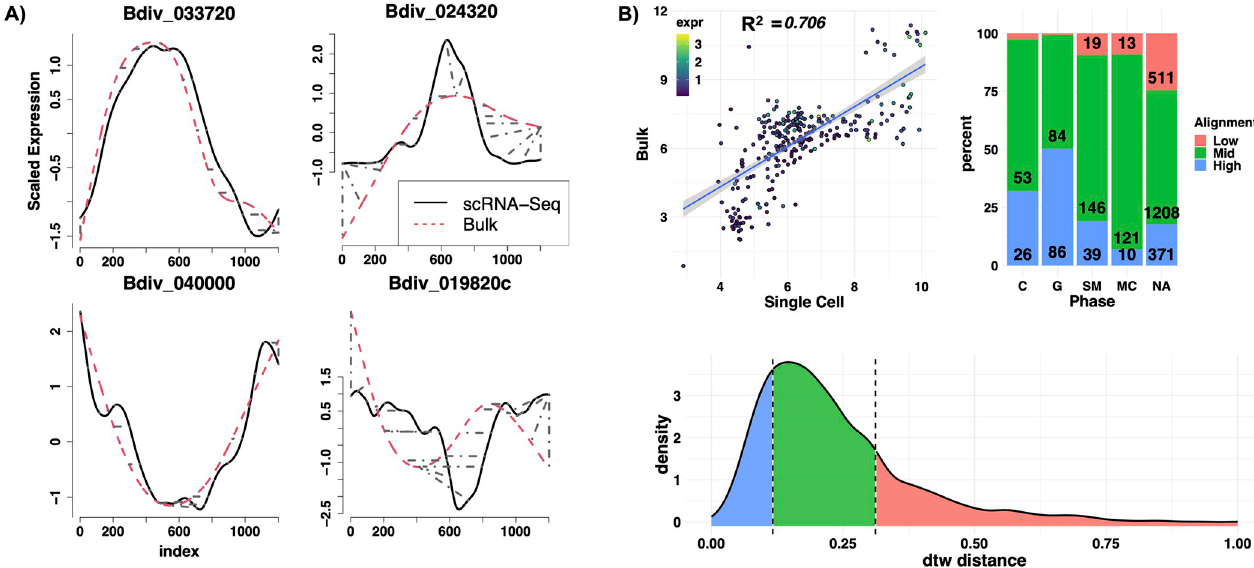
Fig 3. Quantification of alignment of gene curves between synchronized bulk and single-cell sequencing. (A) Dynamic time warping alignment of a sample gene: high alignments (left), low alignments (right). Gray dashed lines indicate the matched time index (warping). (B) Top left: Correlation between calculated peak times in S/M/C phases, excluding the boundary. Top right: Percent alignment distance AU : InthelegendforFig 3 : Pleasecheckthattheeditstothesentence } Percentalignmentdistance ::: } captureyourmeaning : Ifnot ; pleaseprovidecorrectwording : categorized into high (distance < lower 20th percentile), low (distance > upper 80th percentile), and mid. Curves with no peak contain a higher percentage of poor alignment. Bottom: Distribution of dynamic time warping (dtw) alignment distance between single-cell and bulk sequencing. Shaded areas show boundaries of alignment categories. NA, not available. AU : PleasecheckthatnotavailableisthecorrectdefinitionofNAinthefigurelegendforFig 3 : Ifnot ; pleaseeditasnecessary : Data and code for generating the figure are available at https://github.com/umbibio/scBabesiaAtlases.